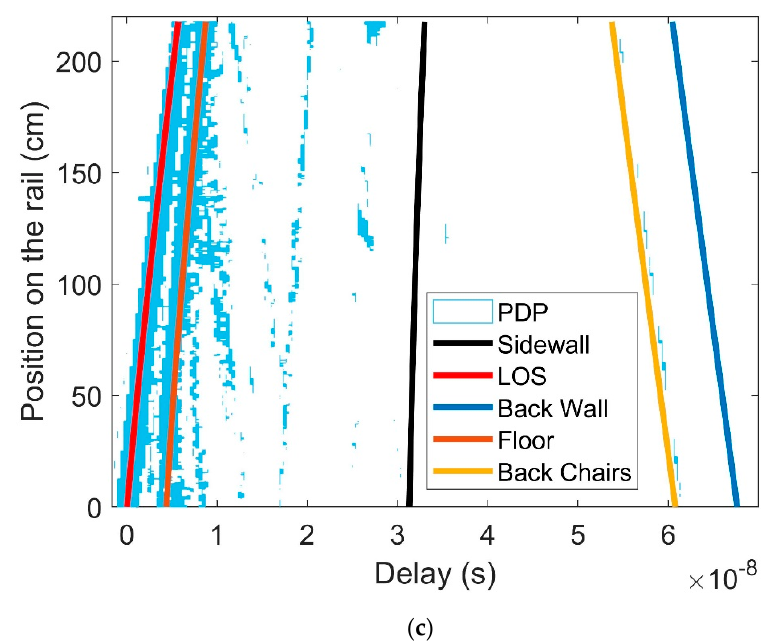
Figure 8. PDP at auditorium, at 41.5 GHz, moving the receiver along the central corridor of the auditorium: ( a ) Received by antenna “2”; ( b ) by antenna “3”; ( c ) by antenna “4”.